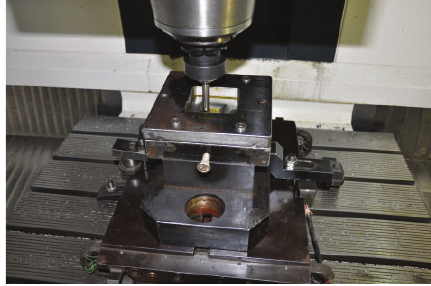
Figure 1: The experimental layout.